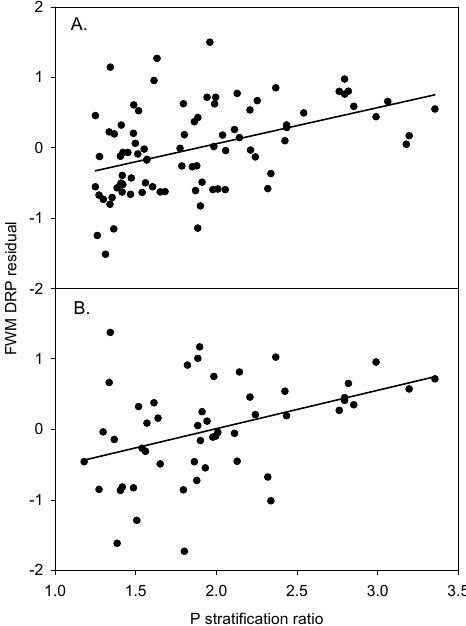
Figure 3. Correlation between residual FWM DRP (from regression of agronomic STP (0–20 cm depth) vs. natural log transformed FWM DRP concentrations) and the P stratification ratio for tile drainage ( A ) and surface runoff ( B ).